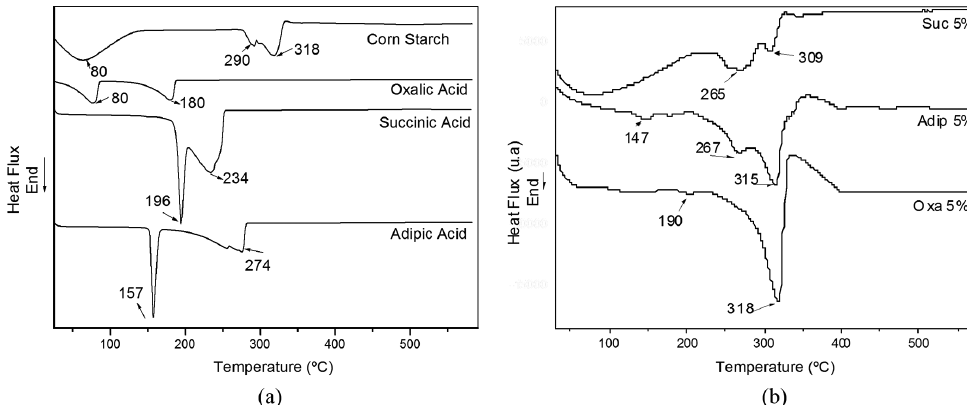
Figure 2. DSC curves of the precursors (a) and biofilms (b).